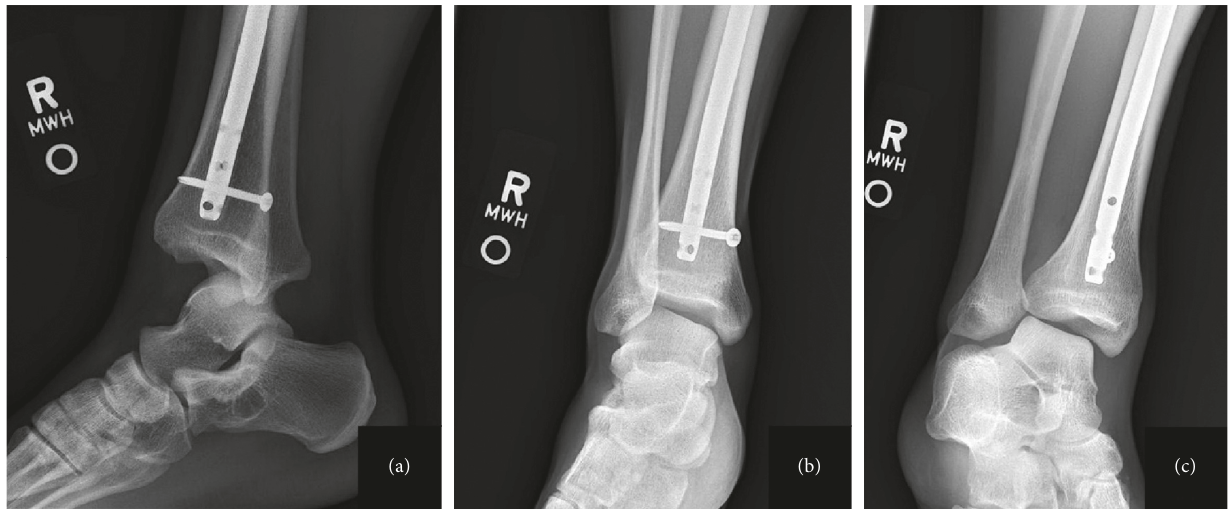
Figure 1: Preoperative lateral (a), AP (b), and mortise (c) radiographs showing tibiotalar dislocation and impingement of the fibula behind the tibia with no fractures.